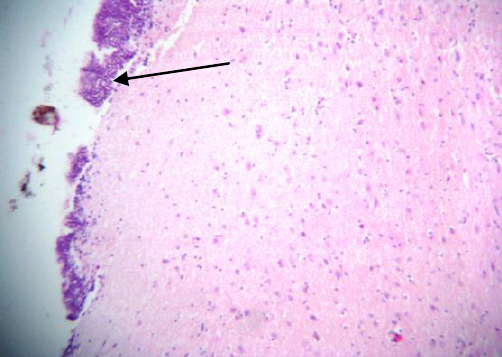
Fig (14):brain at day 6 pi. showed microgliosis ( ) (